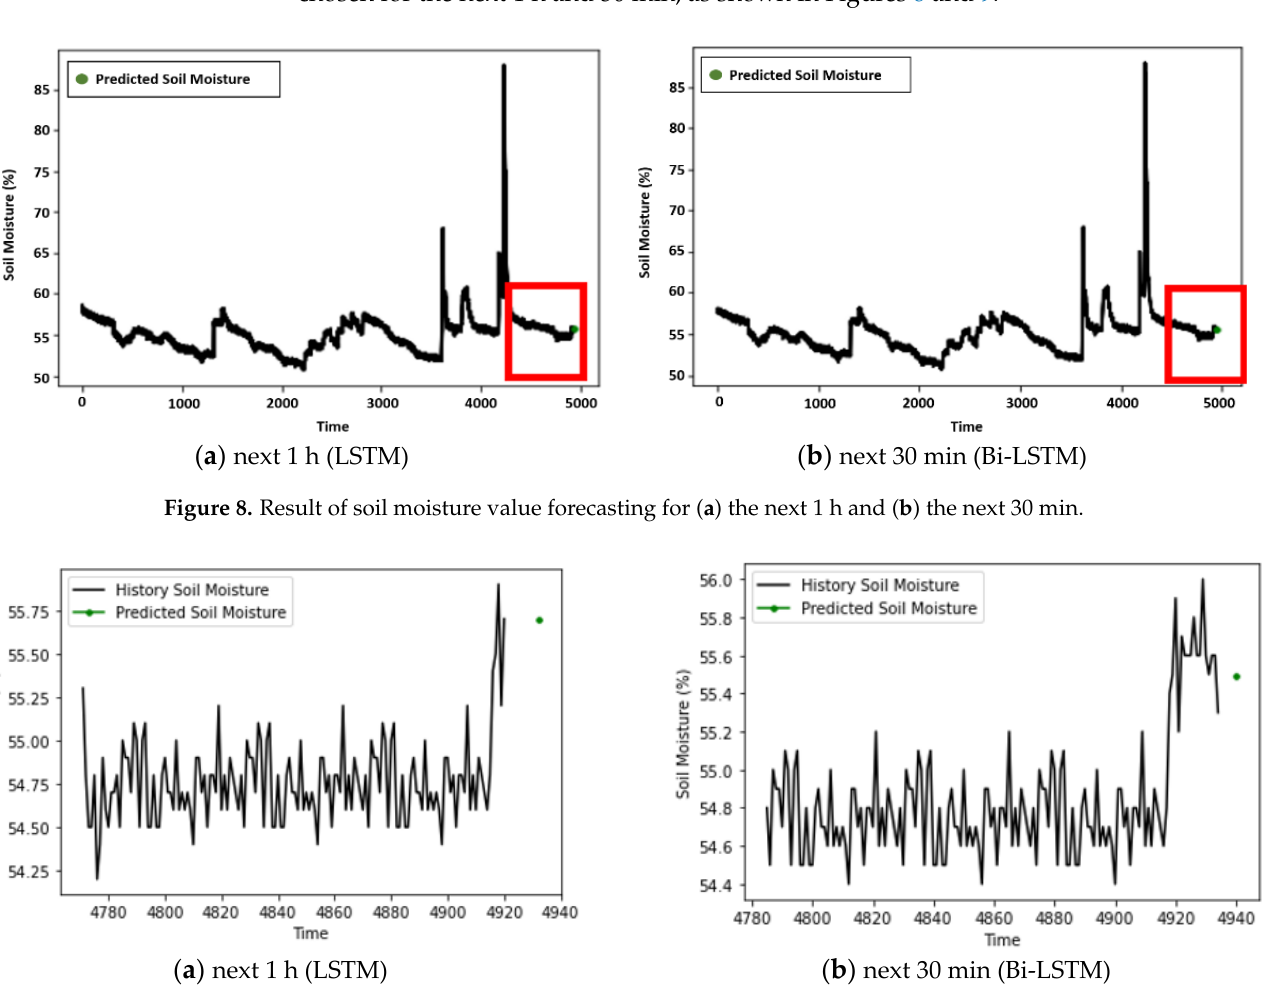
Table 8. Comparison of cross-validation result of soil moisture forecasting model (LSTM and Bi- LSTM).